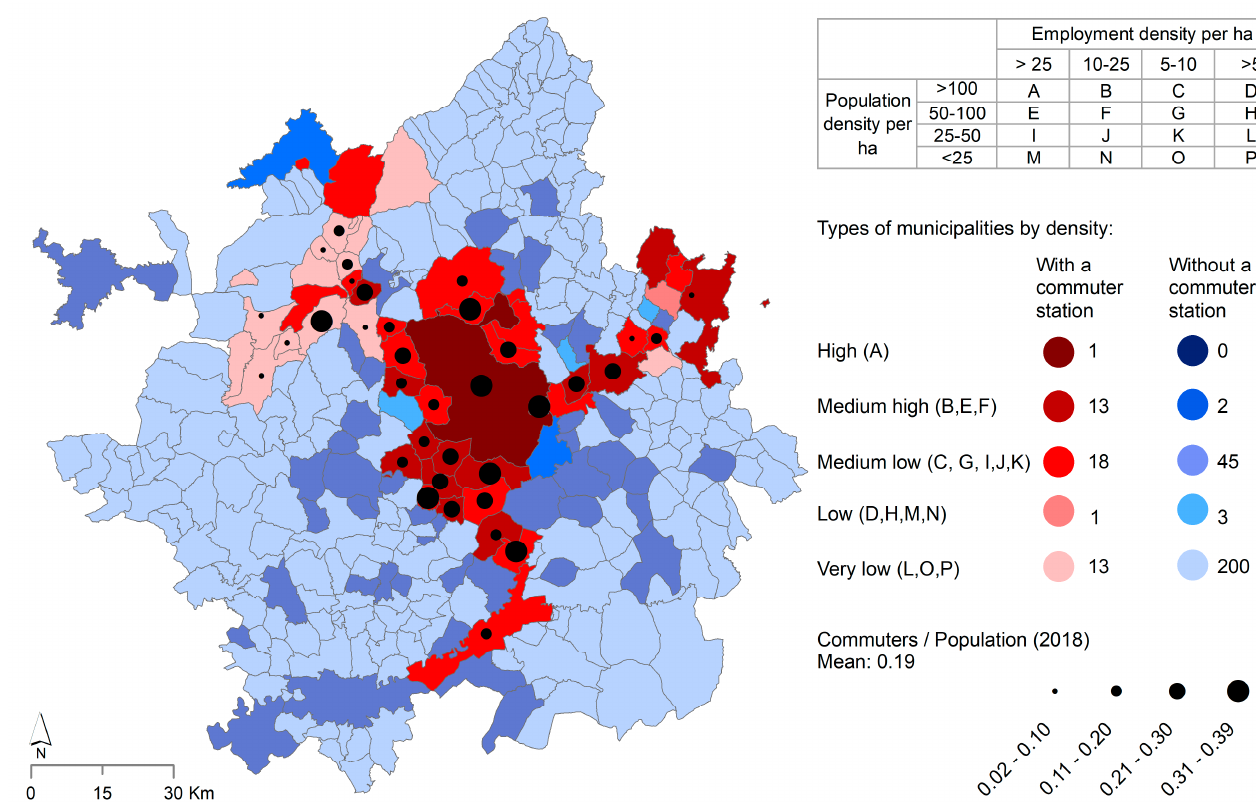
Figure 2. Typology of municipalities by population and employment densities and by the rail commuters-to-population ratio in 2018.